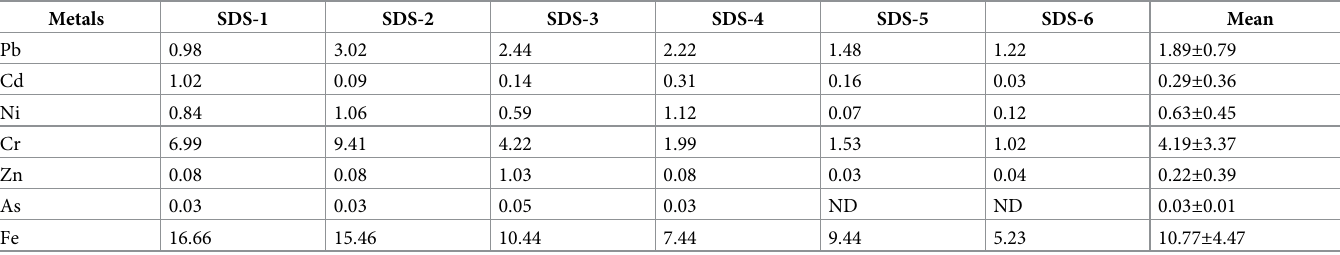
Table 2. Heavy metal concentrations (mg/kg) in sediment during the dry season. Metals